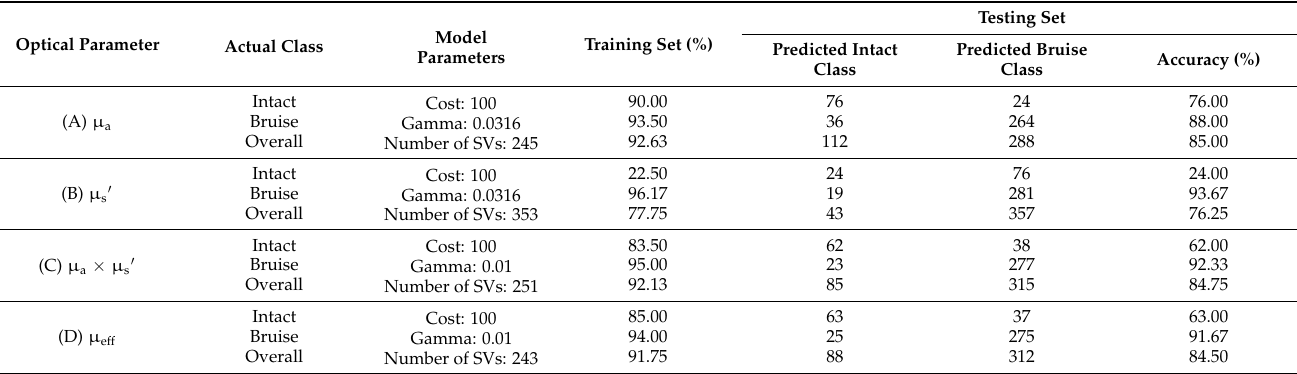
Table 4. Classification results for bruised peach samples via Support Vector Machine (SVM) model using optical parameters ( µ a , µ s (cid:48) , µ a × µ s (cid:48) , and µ eff ) over 550–1000 nm *. Optical Parameter Actual Class Model